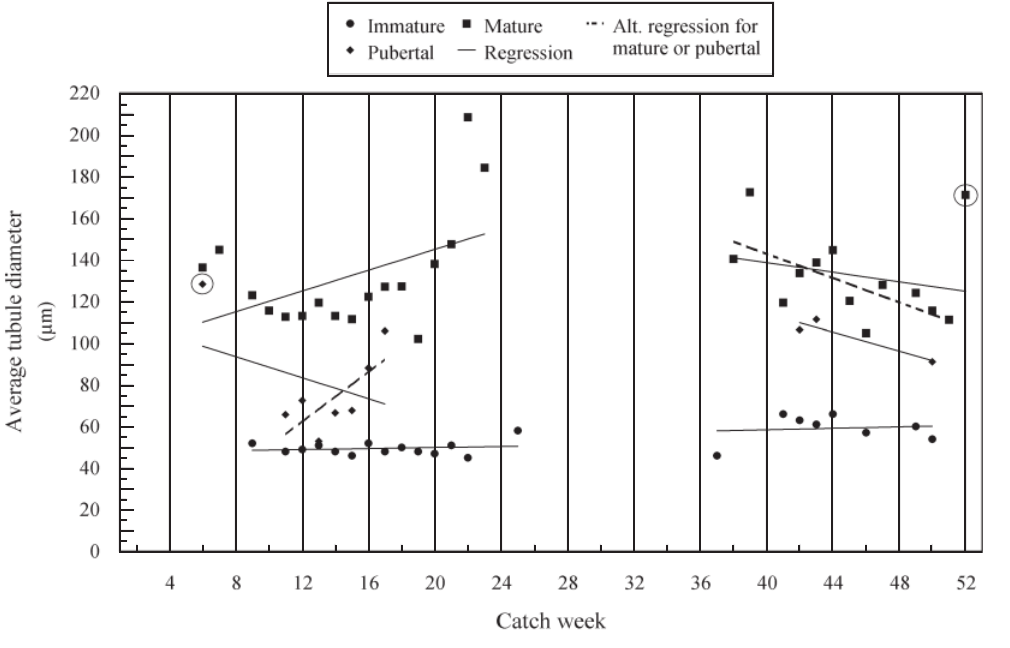
Fig. 4. Seasonal varia- tion of average seminiferous tubule diameter in immature, pubertal and mature animals by catch week. Linear regres- sion lines are shown. Circles points are excluded in alternate